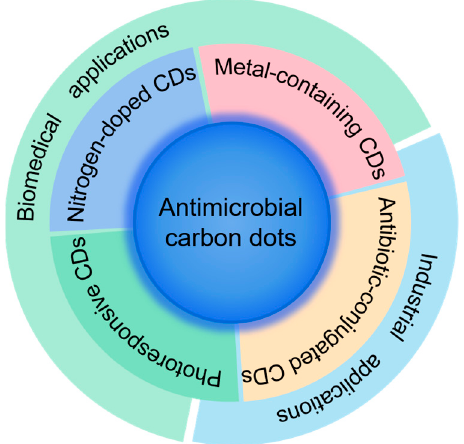
Scheme 1. Scheme illustrating the different types of antimicrobial CDs for biomedical and industrial